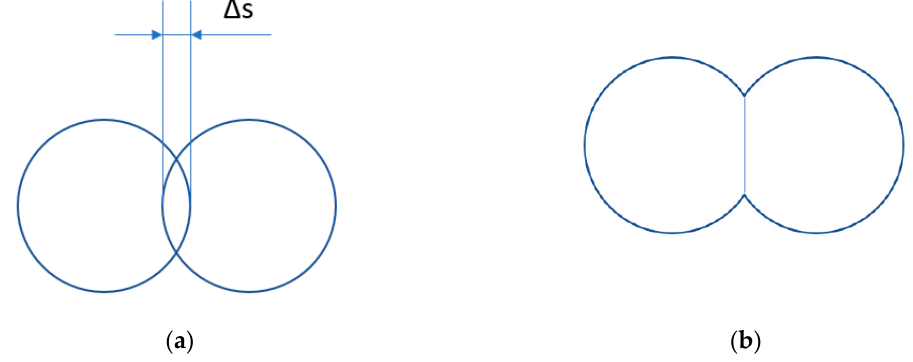
Figure 2. Collisions of particles: ( a ) real, ( b ) numerical model— Δ sn is the overlay of particles in the normal direction.